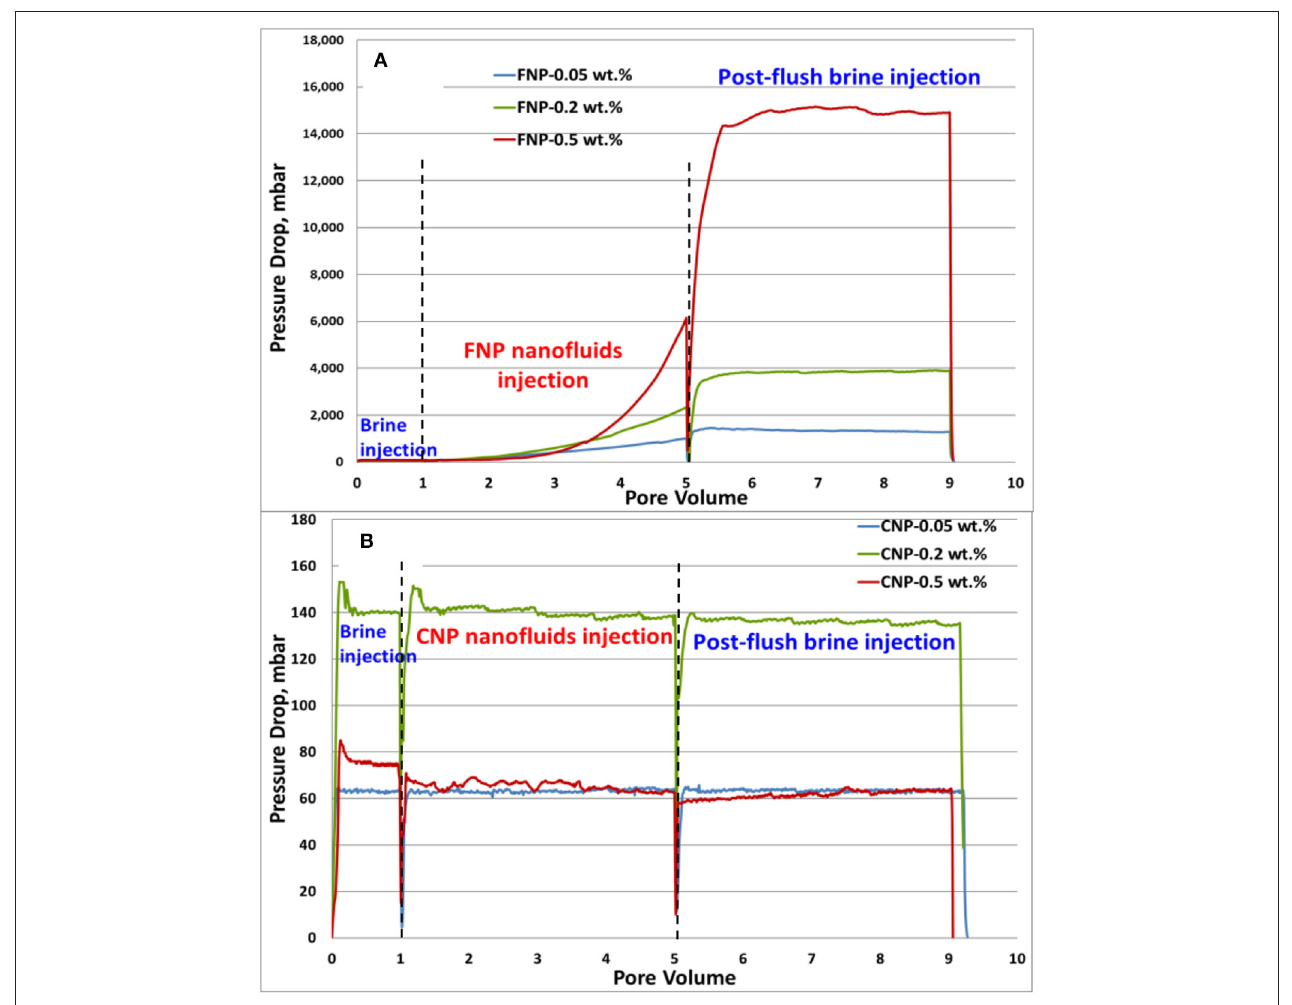
FIGURE 11 | Differential pressure curves for nanoparticles transport experiment: (A) core plugs treated with FNP; (B) core plugs treated with CNP.